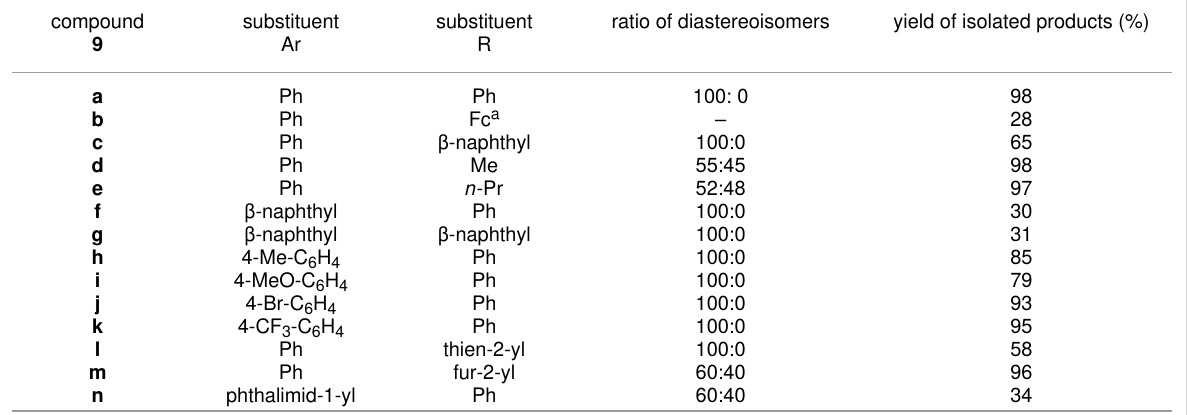
Table 1: Ferrocenyl-substituted tetrahydrothiophenes 9a – n obtained in reactions of D–A cyclopropanes 5a – h with ferrocenyl thioketones 8a – g cata- lyzed with Sc(OTf) 3 . compound substituent substituent ratio of 9 Ar R